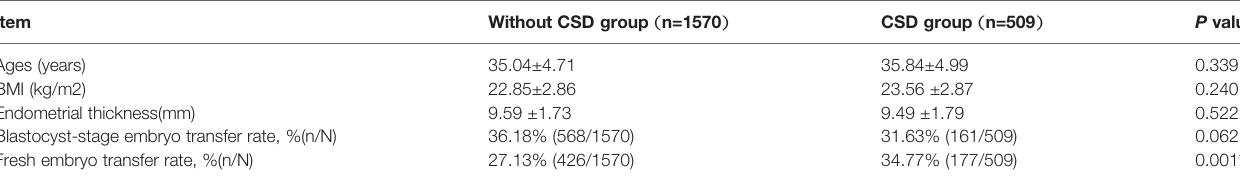
TABLE 4 | Baseline characteristics of patients with and without CSD.